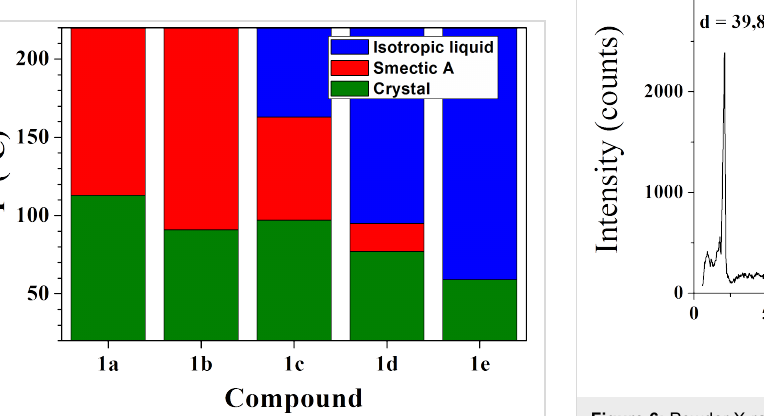
Figure 5: Phase transition temperatures of compounds 1a–e .